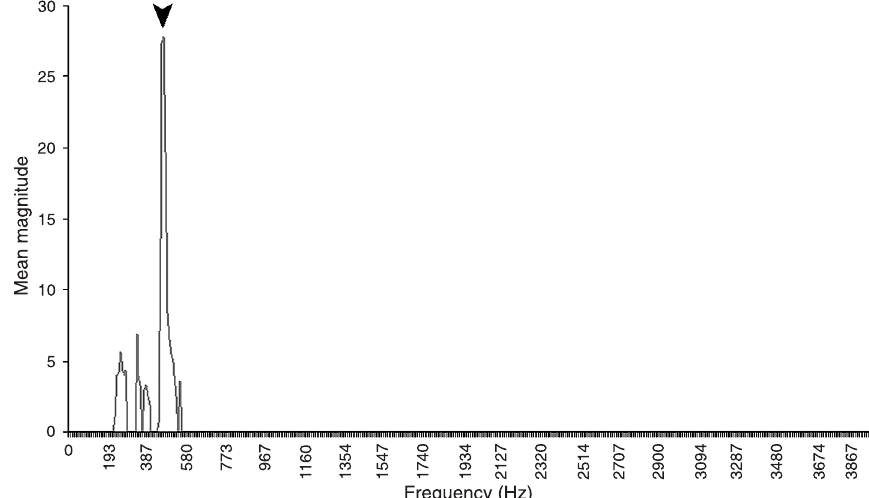
Figure 8. Spectral projection of the processed spectro- gram. The arrowhead